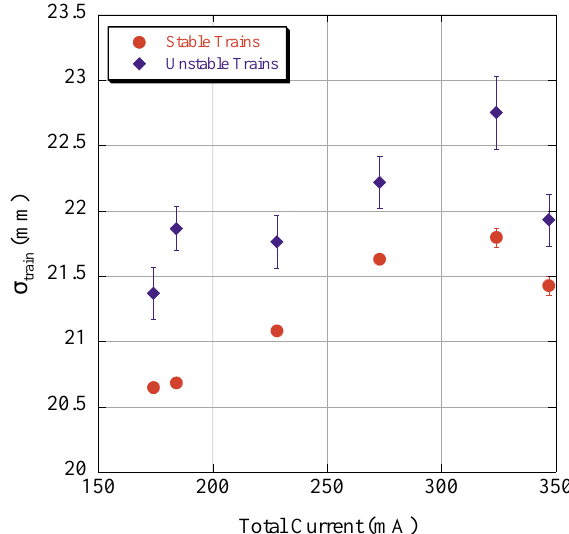
FIG. 28. (Color) The temporal spread of the trains with and without the instability present.